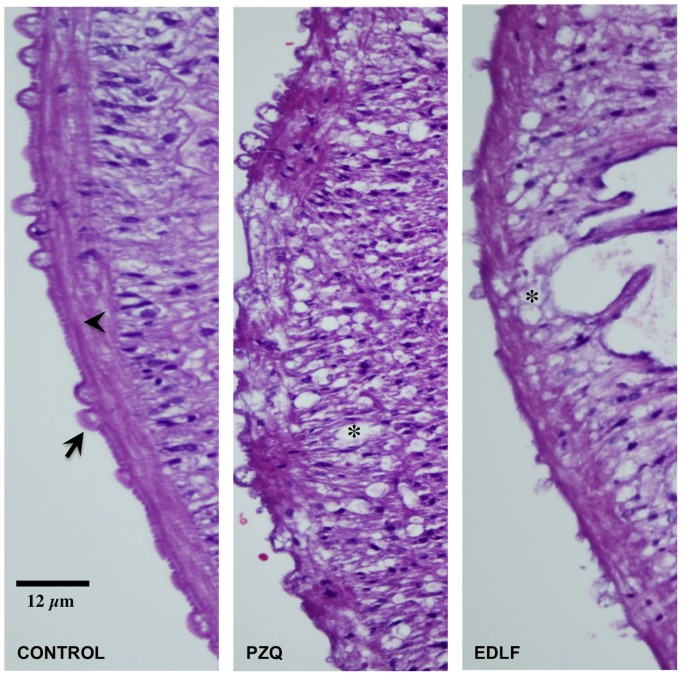
Morphological changes in S. mansoni adult worms following praziquantel or edelfosine treatments.H&E stained sections of freshly recovered male parasites that were untreated (Control) or treated with 10 µM praziquantel (PZQ) or 20 µM edelfosine (EDLF) for 2 days. Tubercle collapse (arrow), damages of the tegument surface, vacuolization of the subtegumental cells (asterisk) and destruction of muscle layers (arrowhead) were observed after treatment with PZQ or EDLF.